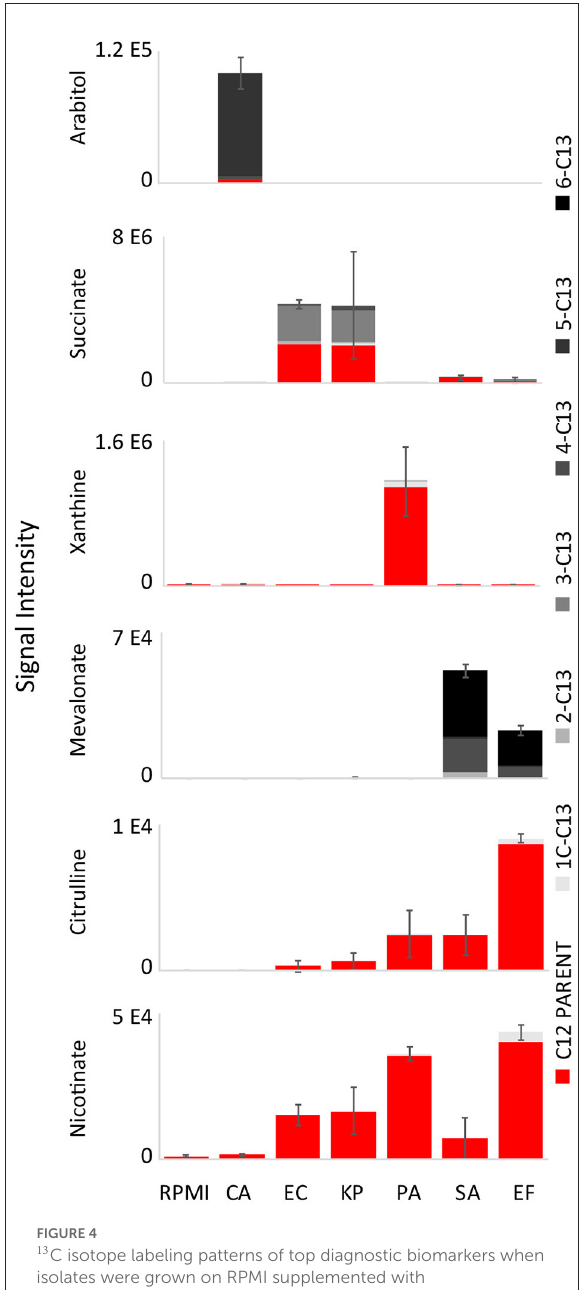
FIGURE4 13 C isotope labeling patterns of top diagnostic biomarkers when isolates were grown on RPMI supplemented with [U- 13 C]glucose. Labeling patterns show that glucose is the primary precursor for arabitol and mevalonate, and partially responsible for succinate production (Source Data File 4). Urocanate, xanthine, citrulline, and nicotinate are fully unlabeled, and thus must be derived from other carbon sources present in the medium. RPMI, Roswell Park Memorial Institute medium; CA , Candida albicans ; KP , Klebsiella pneumoniae ; EC , Escherichia coli ; PA , Pseudomonas aeruginosa ; SA , Staphylococcus aureus ; EF, Enterococcus faecalis . Data are presented as mean values + / − SD of total signal of n = 3